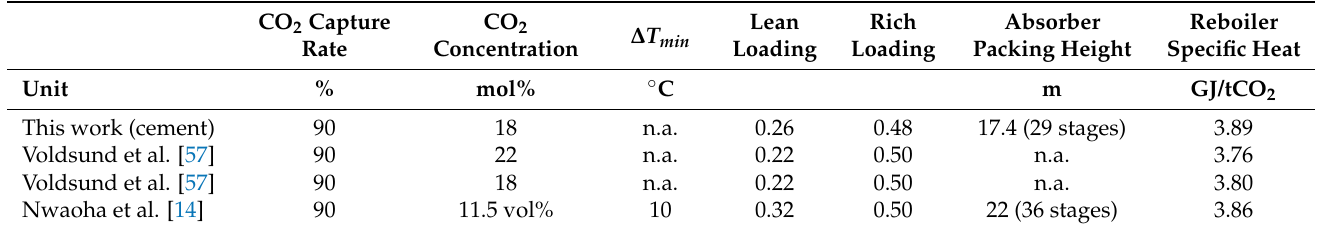
Table 6. Comparison of the cement plant’s flue gas process simulation results with